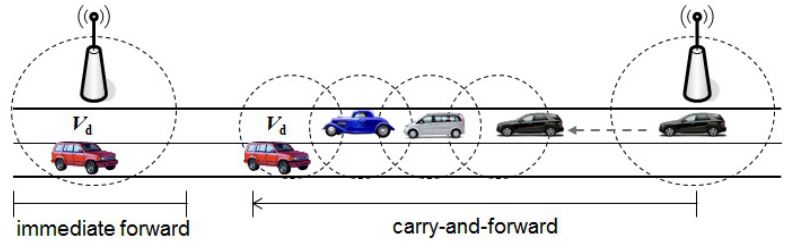
Figure 3. Message forwarding from an RSU to a destination